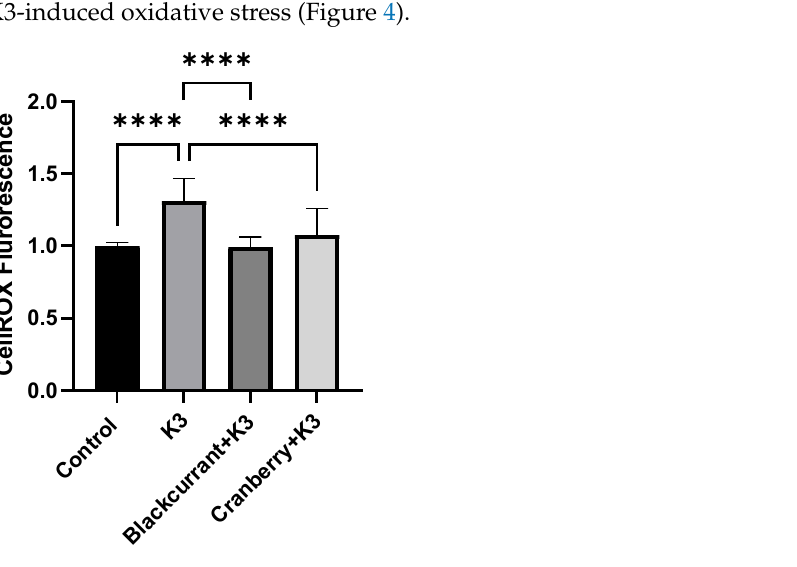
Figure 4. Effects of berry extracts on oxidative stress in BV-2 cells. Mean normalized CellROX TM fluorescence from experiments ( n = 12) demonstrating the effect of berry extracts on menadione (Vitamin K3) induced oxidative stress in BV-2 cells. In each experiment, CellROX TM fluorescence was normalized to the Control. K3 (100 µM) elicited a significant increase in CellROX TM fluorescence (**** p < 0.0001) indicating a marked increase in oxidative stress. Both cranberry (100 µg/mL) and black currant extract (100 µg/mL) inhibited oxidative stress induced by menadione (**** p < 0.0001).